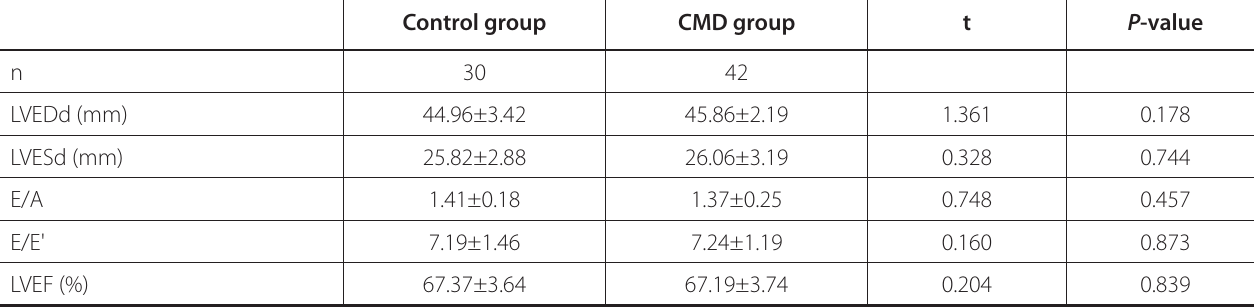
Table 2 . Comparison of parameters detected by colour Doppler echocardiography between the